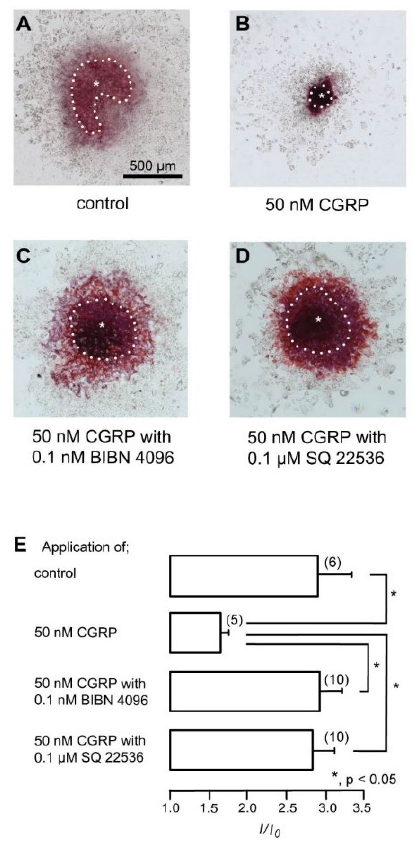
Figure 6. CGRP receptor signaling regulates the defensive reaction of odontoblasts. ( A – D ) Isolated rat dental pulp slices were cultured for 7 days in a mineralization medium without pharmacological intervention ( A ) or with 50 nM CGRP ( B ), 50 nM CGRP with 0.1 nM BIBN 4096 ( C ), or 50 nM CGRP with 0.1 µ M SQ22536 ( D ) at pH 7.4 and stained using Alizarin red (red, calcium deposition). White dotted lines indicate the borderline between mineralized odontoblasts and dental pulp. Asterisks indicate the dental pulp area. Data were obtained using a 20 × magnification objective lens under a microscope. Each dataset was tiled with 63 photos to acquire the constructed data. To obtain data on the mineralized area constituted by odontoblasts, the mineralized area in the total area ( I ) was divided by the mineralized area of the dental pulp ( I 0 ). ( E ) The estimated mineralization levels were 2.89 ± 0.43 I / I 0 in the absence of CGRP receptor modifiers (as controls), 1.64 ± 0.1 I / I 0 with 50 nM CGRP, 2.91 ± 0.29 I / I 0 with 50 nM CGRP and 0.1 nM BIBN 4096, and 2.82 ± 0.29 I / I 0 with 50 nM CGRP and 0.1 µ M SQ22536. Each column denotes the mean ± SE of each experiment. Statistically significant differences between columns (shown by solid lines) are indicated by asterisks. * p <